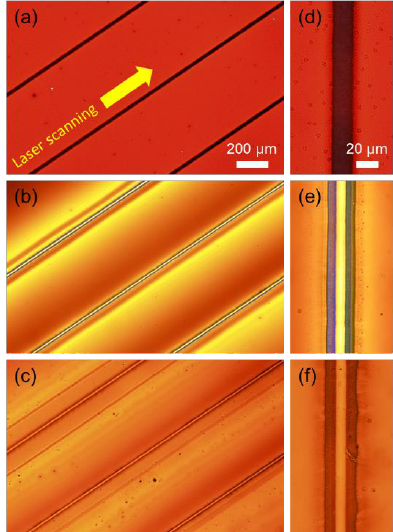
Figure 1. ( a ) Schematics of the proposed laser micropatterning for Ag NP ink; ( b ) The process flow of (i) the previous studies on SLS process for Ag NP ink and (ii) the proposed method.